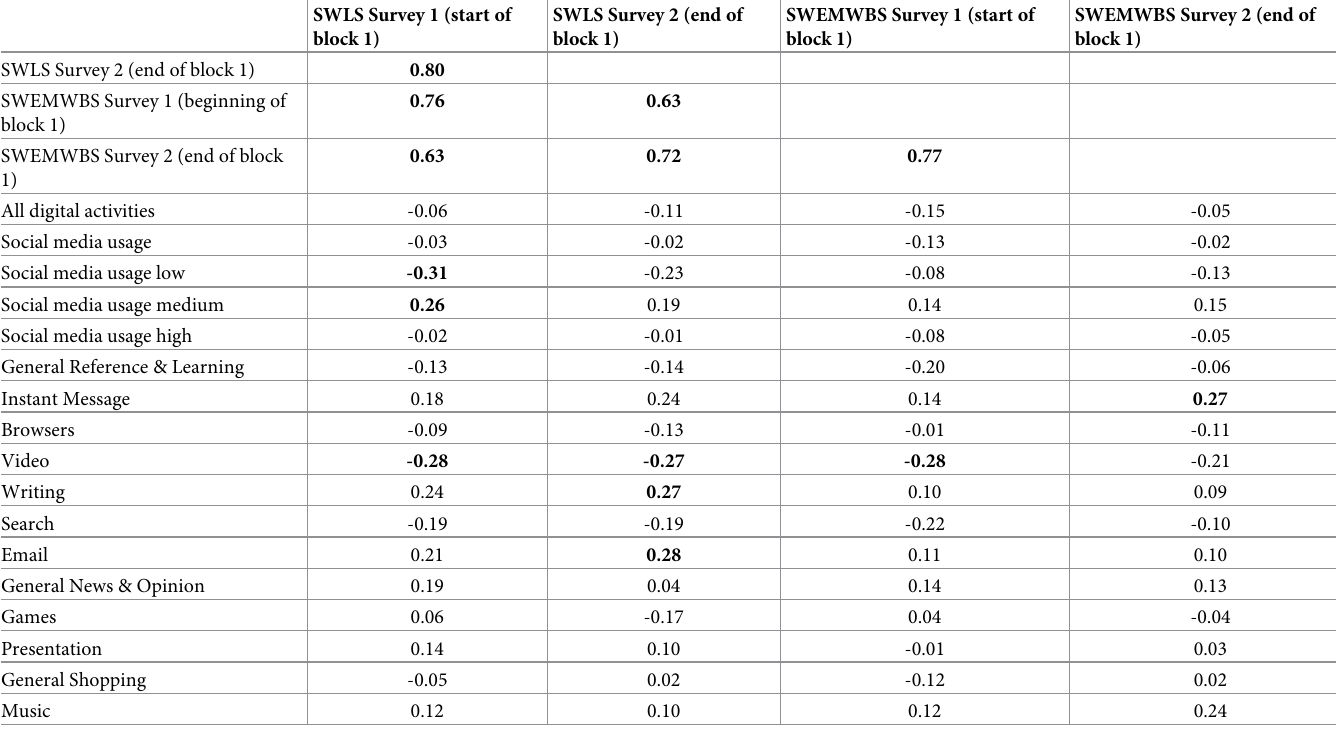
Table 4. Correlations of subjective well-being measures and digital activities in block 1 (Android